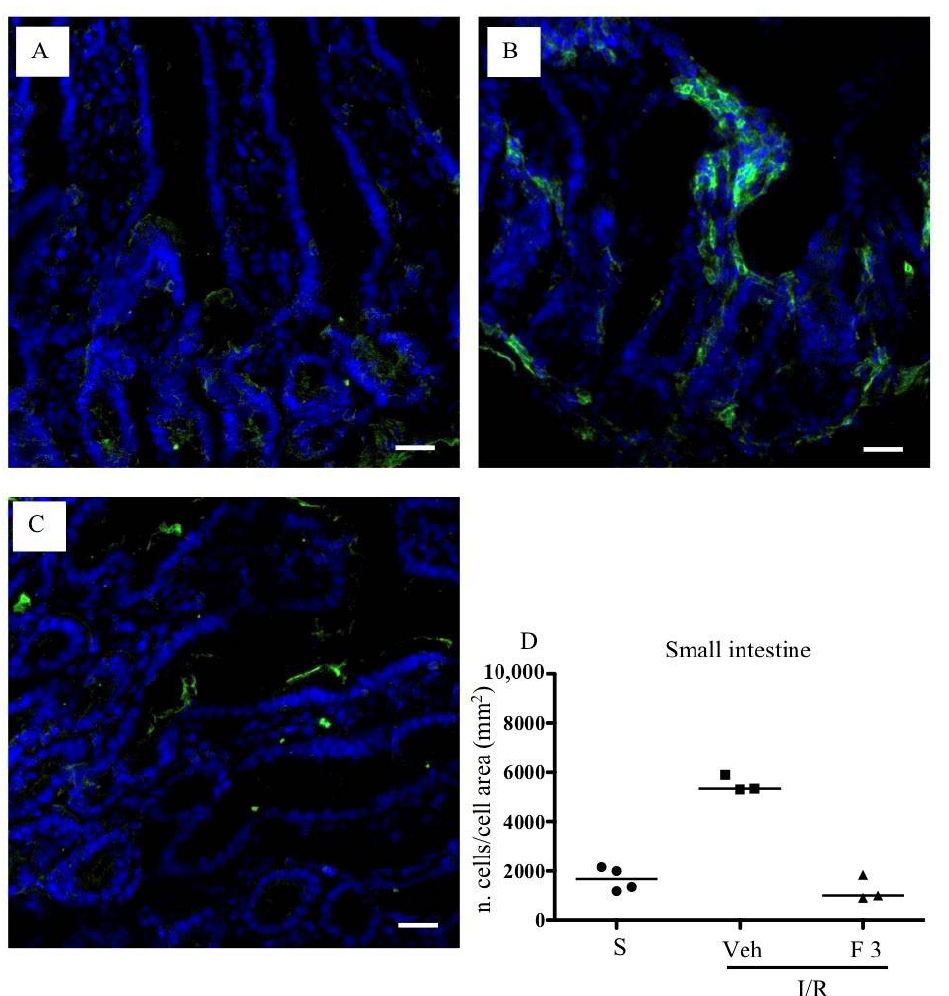
Figure 3. Effects of FTY720 on I/R-induced CD11b + cell recruitment in the small intestine. Representative immunofluorescence-stained sections visualizing CD11b + cells (green fluorescence) in intestinal tissues excised from S mice ( A ) and from I/R mice administered with vehicle ( B ) or FTY720 3 mg/kg i.v. ( C ). Images were taken at 63× magnification through the oil immersion objective (scale bar: 25 μm). Sections were counterstained with DAPI for nuclear morphology (blue fluorescence). ( D ) Ratio of the number of CD11b + cells divided by the cell total area in sections of intestinal tissues excised from vehicle-treated S mice ( n = 4) and I/R mice administered with vehicle (Veh) ( n = 3) or with FTY720 3 mg/kg i.v. (F 3) ( n = 3) (horizontal bar at the median value).